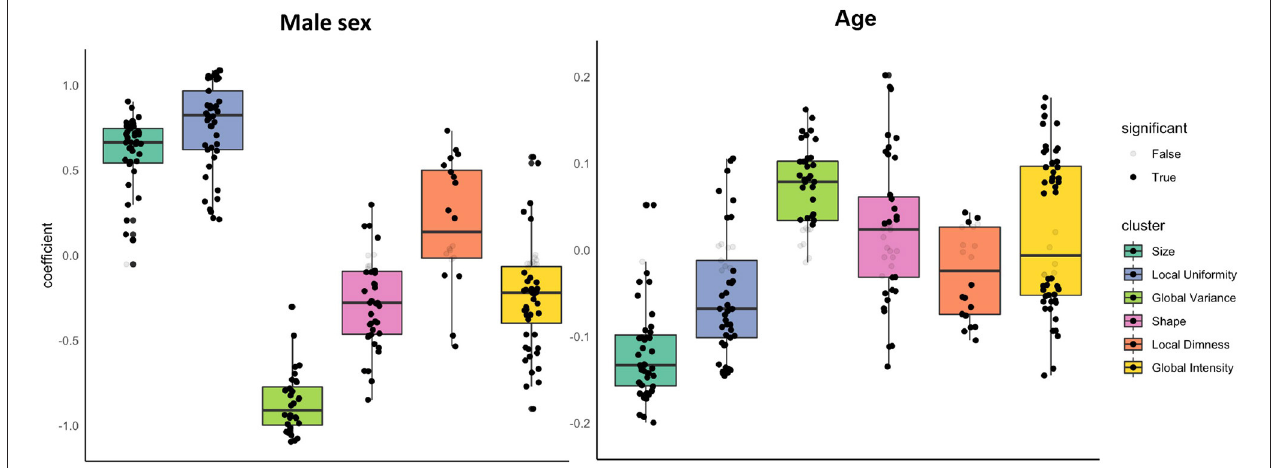
FIGURE 2 | Associations of sex and age with radiomics features in the healthy subset grouped into clusters. Results are from linear regression models adjusted for age, sex, and body surface area. The y axis is standardised beta coefficients for associations of sex (left) and age (right) with radiomics features. Each dot represents point estimate of the association with a radiomic feature from a separate model. Black dots indicate statistically significant associations. Grey dots indicate non-significant associations. Statistical significance is based on Bonferroni adjusted p -value < 0.05. Feature associations are grouped into previously defined clusters ( Figure 1 ; Table 1 ). The dark line in the box plot indicates the median beta coefficient in the cluster, the box borders indicate limits of the interquartile range.